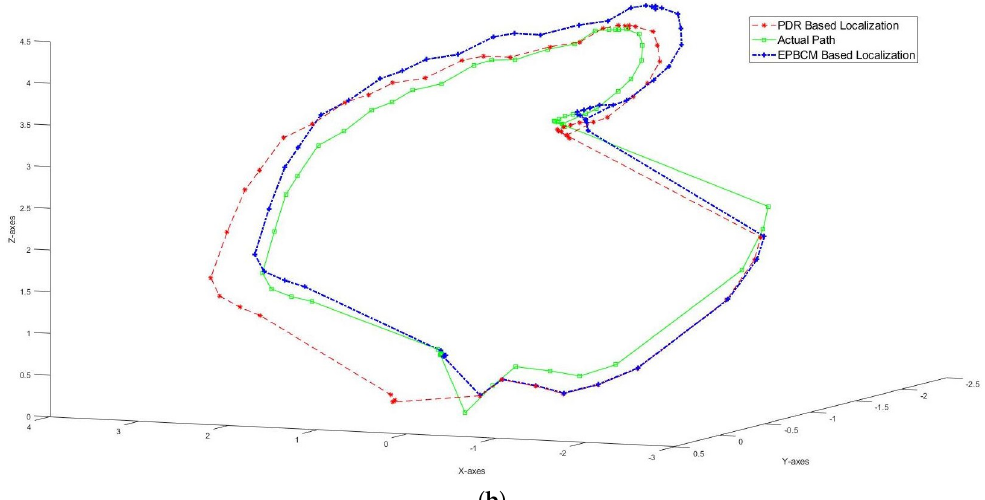
Figure 12. Performance evaluation of the proposed localization model considering pedestrian walking trajectories. (a ) Pedestrian walking experiment; ( b ) Person walking trajectory evaluation by using EPBCM and PDR based localization